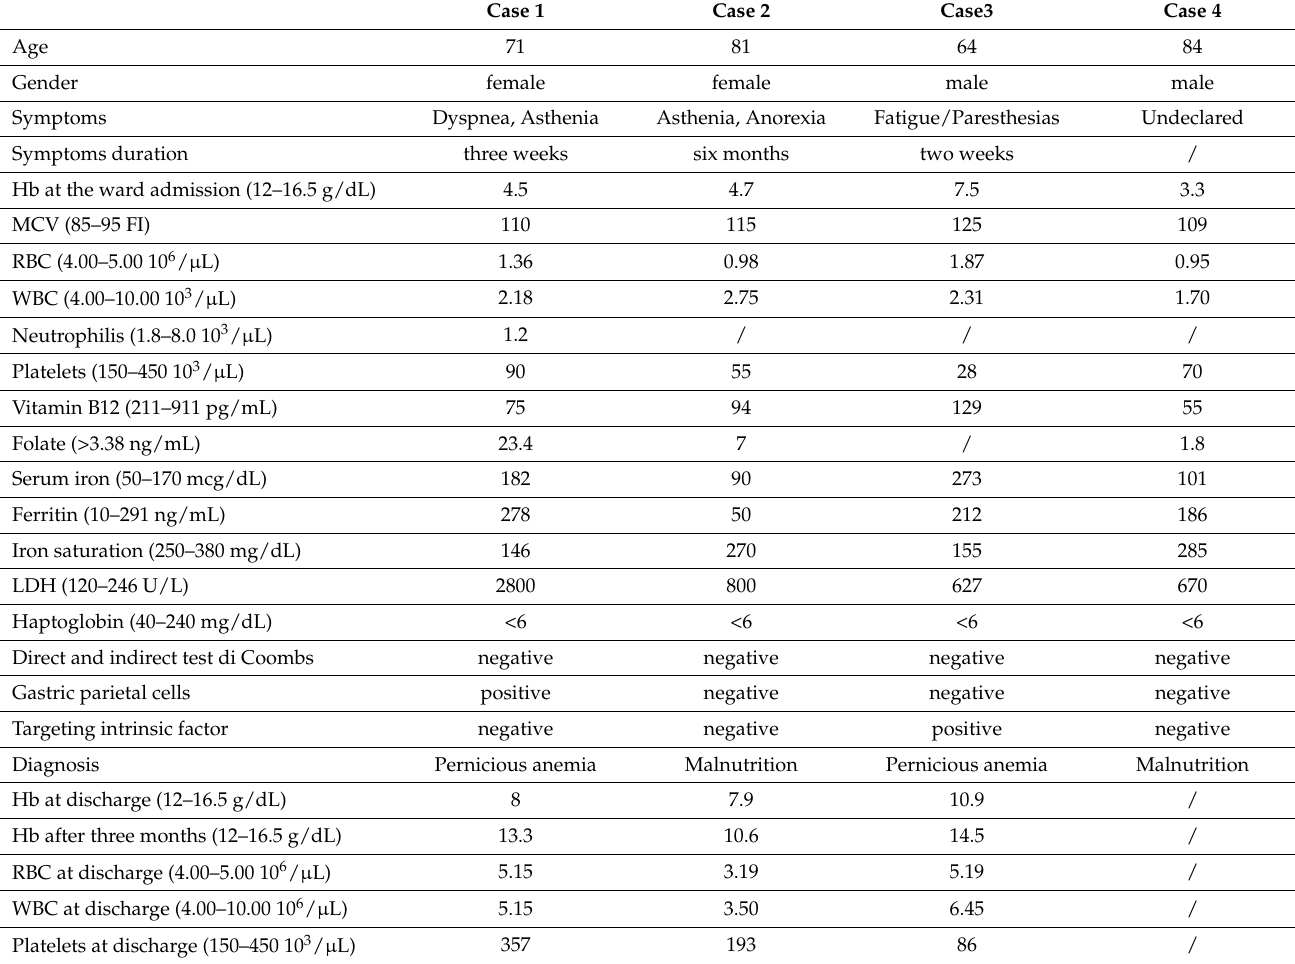
Table 1. Patients’ clinical